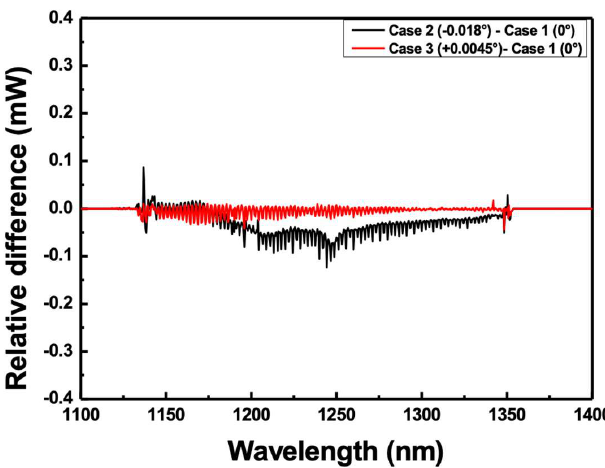
Figure 7. Results of reducing the error for 𝛥𝑦 (cid:3040) after optimization of alignment.